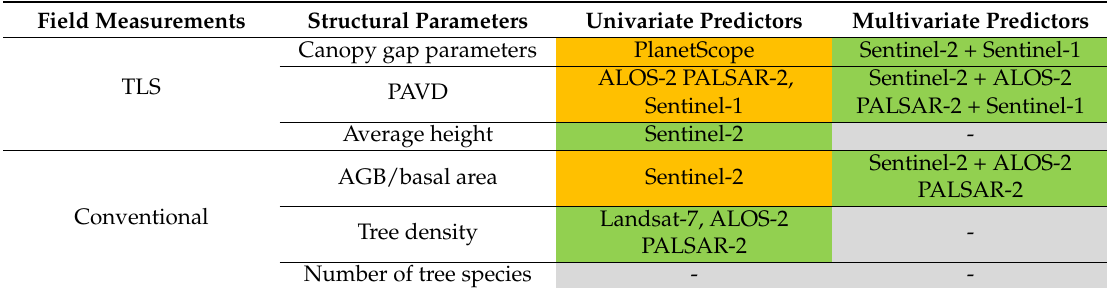
Table 6. Field-measured forest structure parameters estimation through single and fusion of satellite remote sensing for this study. Synthesized based on the correlation results of Table 4 and modeling results of Table 5. Green = best estimators, orange = good